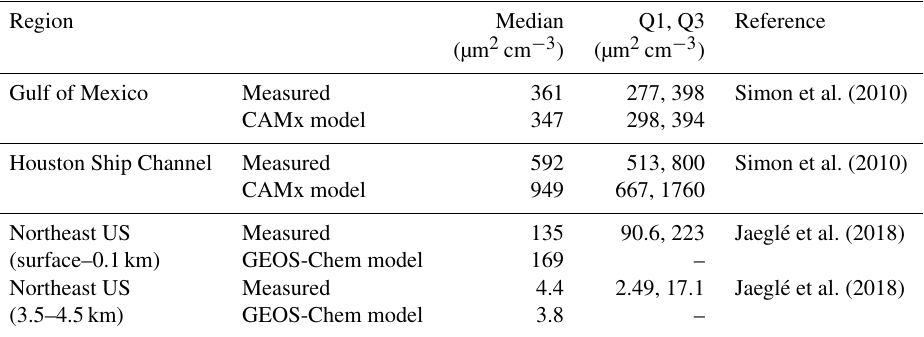
Table 1. Comparison of model and measured aerosol surface area concentrations. Simon et al. (2010) compared CAMx model results with ground-based measurements in the Gulf of Mexico and the Houston Ship Channel. Jaeglé et al. (2018) compared measurements from the WINTER campaign and GEOS-Chem modeled data at the surface and aloft between 3.5 and